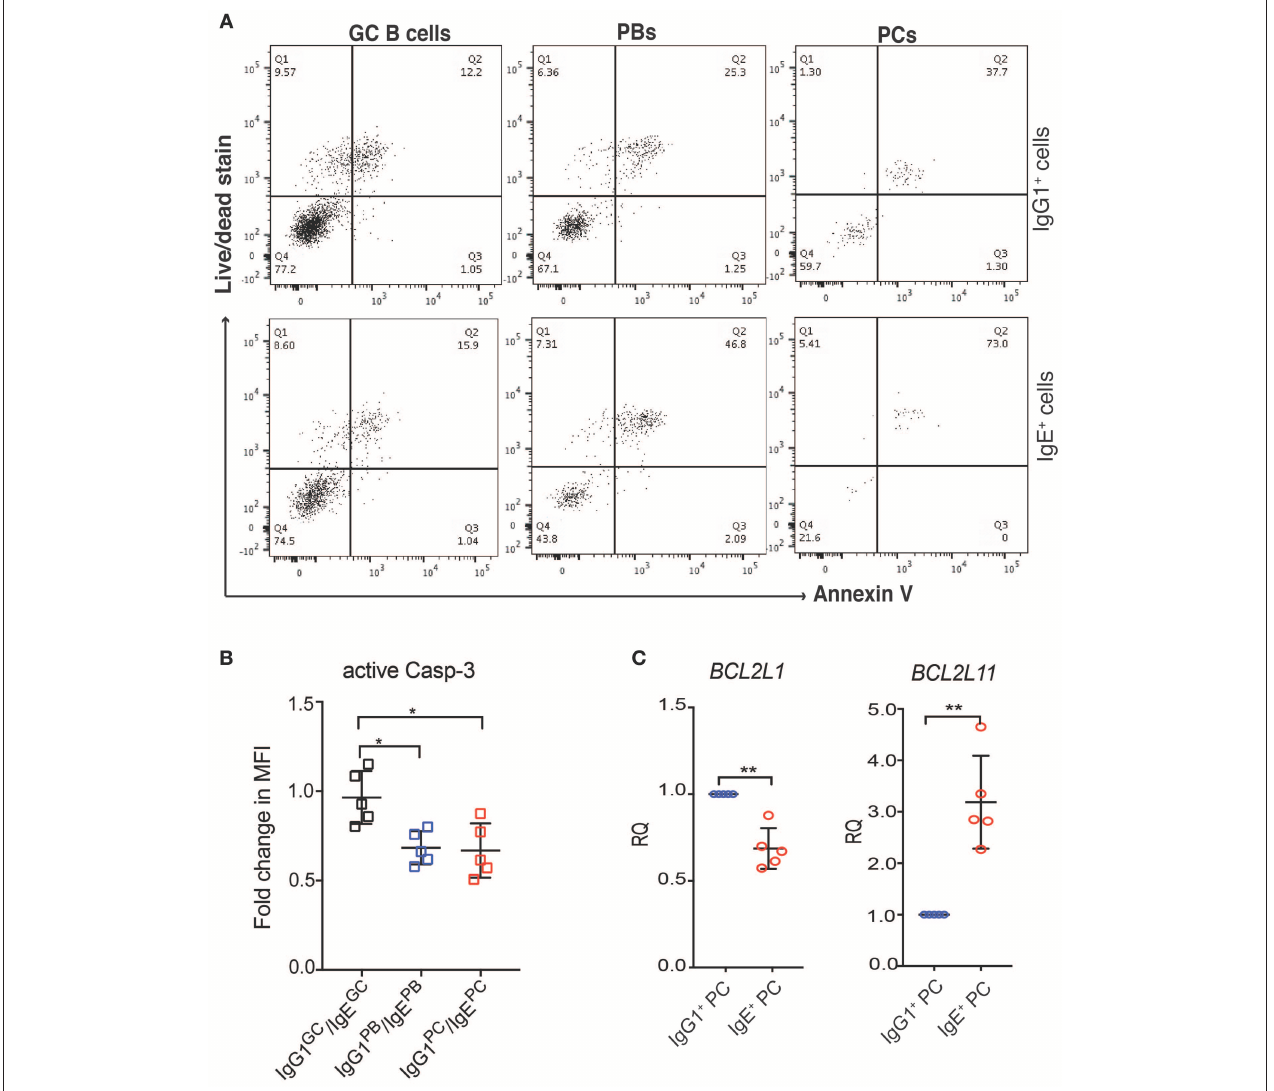
FIGURE 6 | IgE + PCs have increased rates of apoptosis compared to IgG1 + PCs. (A) After 24h of reculture with IL-4 and anti-CD40, the IgE + and IgG1 + cells were stained with annexin V and a live/dead fixable dye. The lower left quadrant within each dot plot (negative for Annexin V and live/dead stain) corresponds to the viable cells and the data shown are representative of three different experiments. (B) On day 10 of the culture, the activity of Caspase 3 was determined by staining with anti-active Caspase 3 antibody. The data show the fold change in MFI of active Caspase 3 within each IgG1 + cell population made relative to their respective IgE + cell counterparts. Statistical analysis was performed using the one way ANNOVA test with Bonferroni correction (* P < 0.05). (C) RT-PCR validation of BCL2L11 and BCL2L1 expression in IgE + and IgG1 + PCs. Data represent the mean + /– SD of the relative quantification (RQ). Statistical analysis was performed using the unpaired t -test with Welch’s correction (* P < 0.05, ** P <